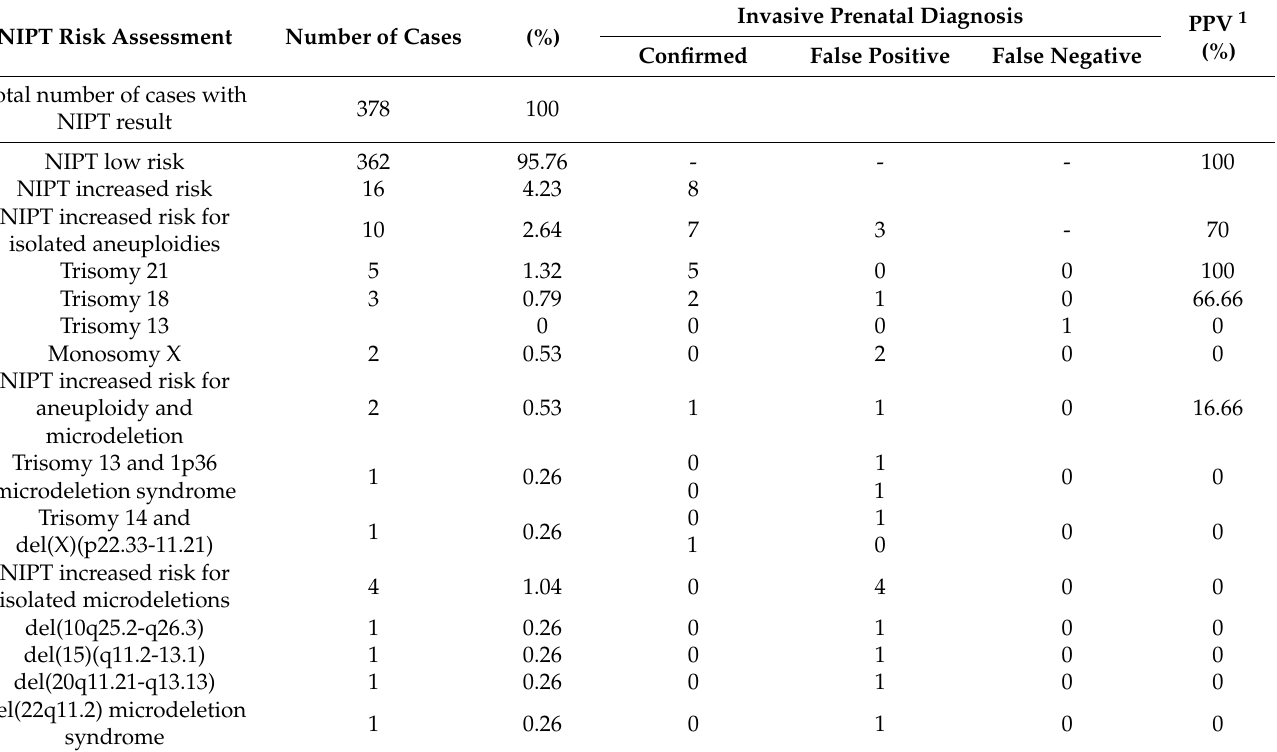
Table 4. The correlation between the risk assessed by NIPT and the final